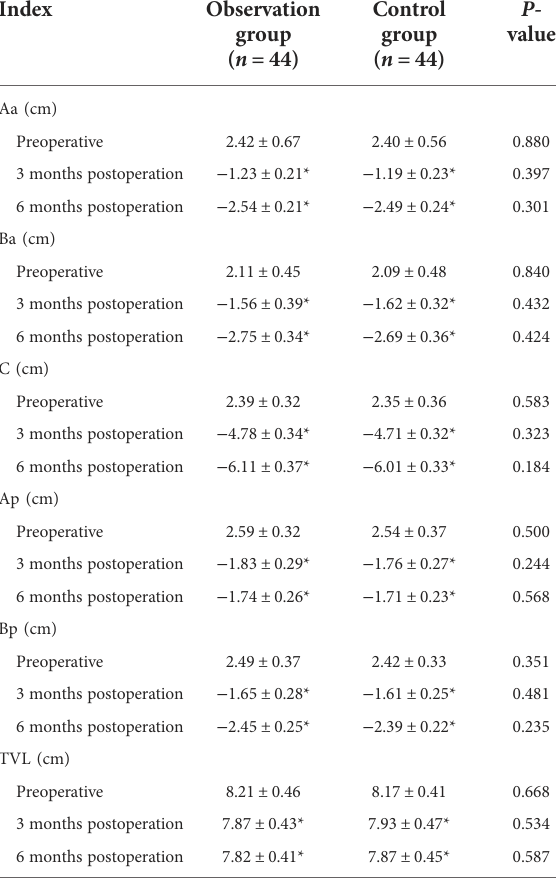
Compared with before operation, * P <0.05. Aa, which is 3 cm from the midline of the anterior vaginal wall to the edge of the hymen, corresponding to the “ bladder urethra fold. ” Ba is the re fl ex of the anterior fornix of the vagina or the farthest position of the vaginal stump from point Aa. C is the intact uterus representing the farthest part of the external cervix, and the hysterectomy is equivalent to the vaginal stump. Ap is 3 cm from the midline of the posterior vaginal wall to the edge of the hymen. Bp is the re fl ex of the posterior fornix of the vagina or the farthest distance from the Ap point of the vagina stump. TVL, Total vaginal length: the total length from the top of the vagina to the edge of the hymen when C and D are in the normal